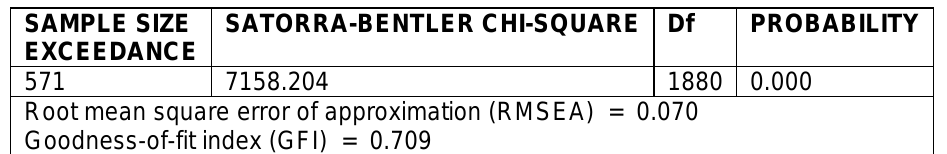
Table 6: fit indices - the influence of marketing strategies on sales growth